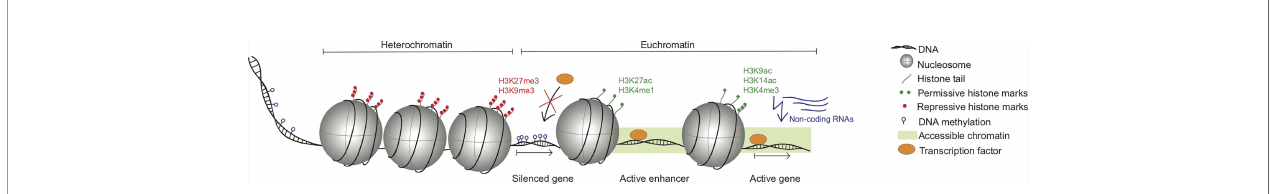
FIGURE 1 | Schematic of different modes of epigenetic regulation. Chromatin in the nucleus is found in two major states: the tightly condensed heterochromatin, and the more lightly packed euchromatin, which is more accessible for transcription. Both in euchromatin and heterochromatin DNA is wrapped around nucleosomes, which are octameric complexes consisting of eight histone proteins. Within this chromatin architecture, different factors regulate the accessibility of the DNA for transcription factors: histone proteins can undergo post-translational modi fi cations, which in fl uence chromatin structure and accessibility in different ways. Histone marks H3K27me3 and H3K9me3 are associated with transcriptional repression, whereas the permissive histone marks H3K27ac and H3K4me1 are found on enhancers and H3K9ac, H3K14ac and H3K4me3 are found on active promoters. On the DNA level, methyl residues dynamically in fl uence the transcriptional activity, whereby methylation of promoters is generally considered to repress transcription. Additionally, non-coding RNAs like miRNAs and lncRNAs can in fl uence gene transcription on diverse levels, thereby adding another layer of epigenetic